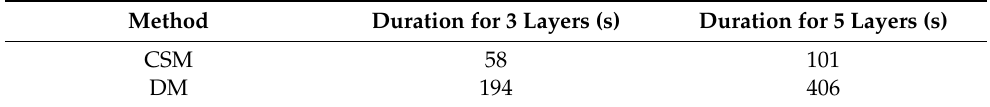
Table 1. Durations of the CSM and the conventional DM.